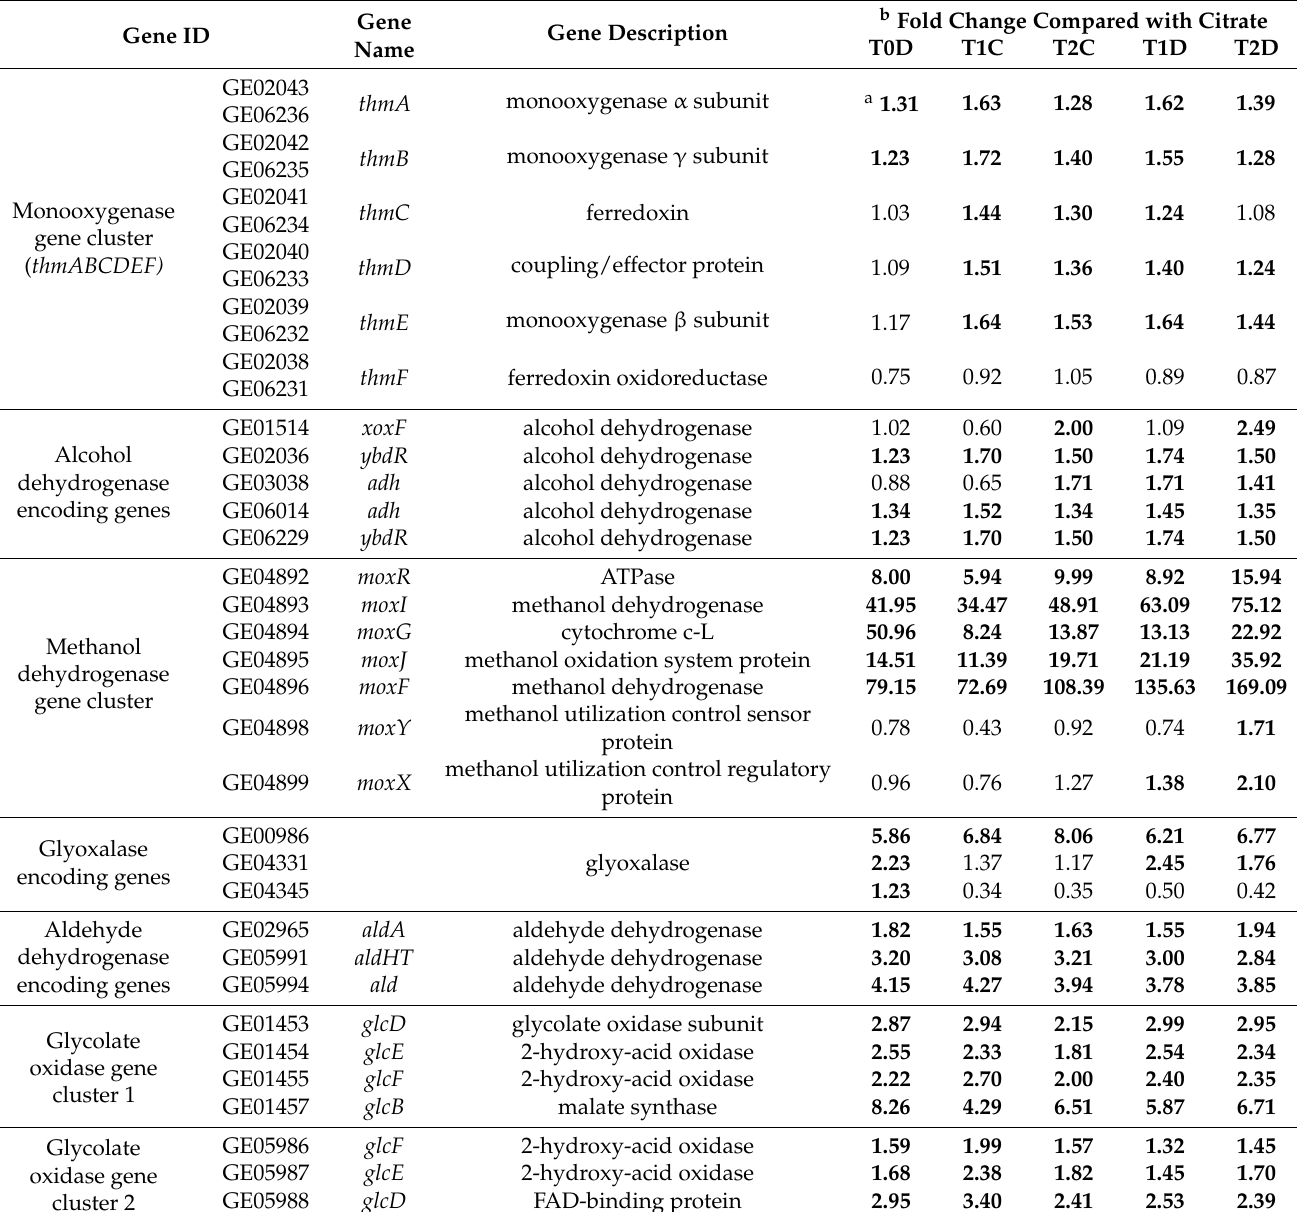
Table 2. Genes involved in catalyzation of dioxane to